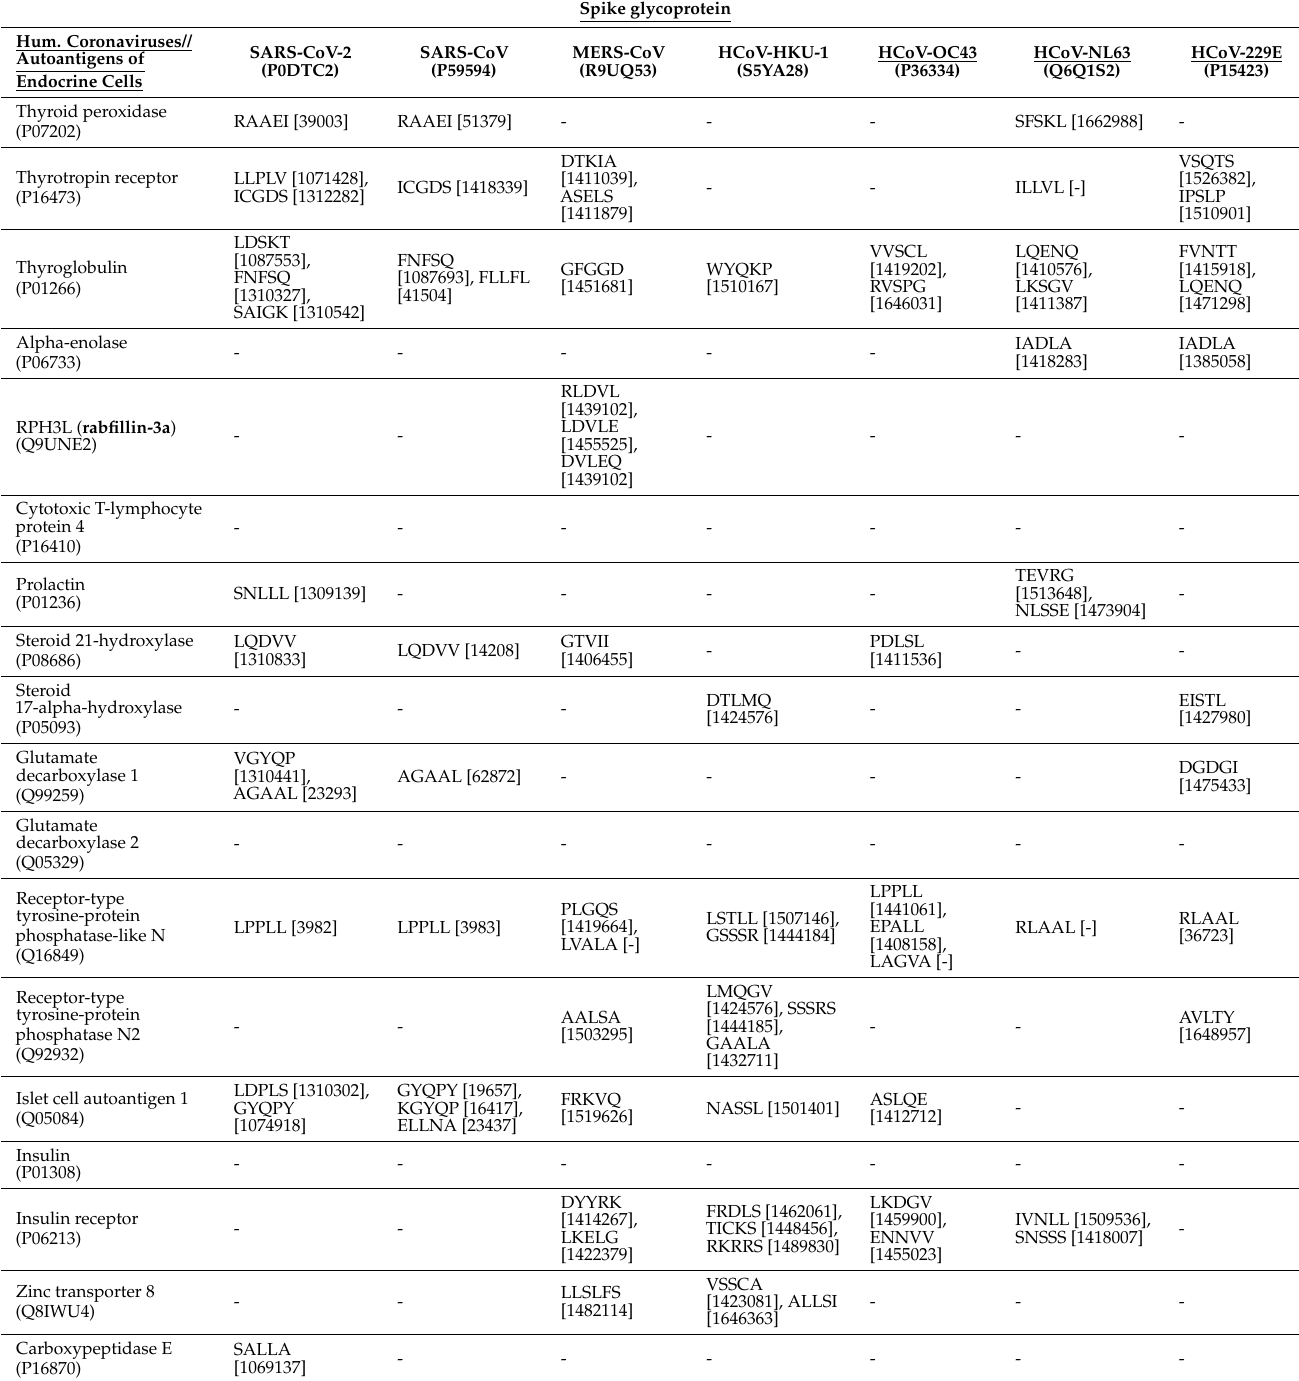
Table 1. Spike glycoprotein of human coronaviruses and autoantigens common for autoimmune endocrinopathies: shared pentapeptides. ID numbers of immunoreactive epitopes from the Immune Epitope Data Base for Human Coronaviruses spike proteins are shown in the square brackets for each